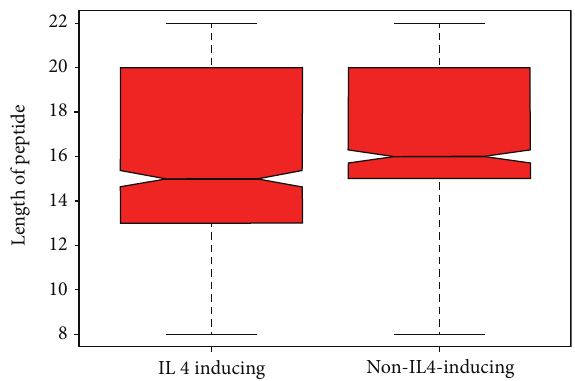
Figure 1: Box plot to represent the variation of peptide length in IL4 inducing and non-IL4-inducing dataset.